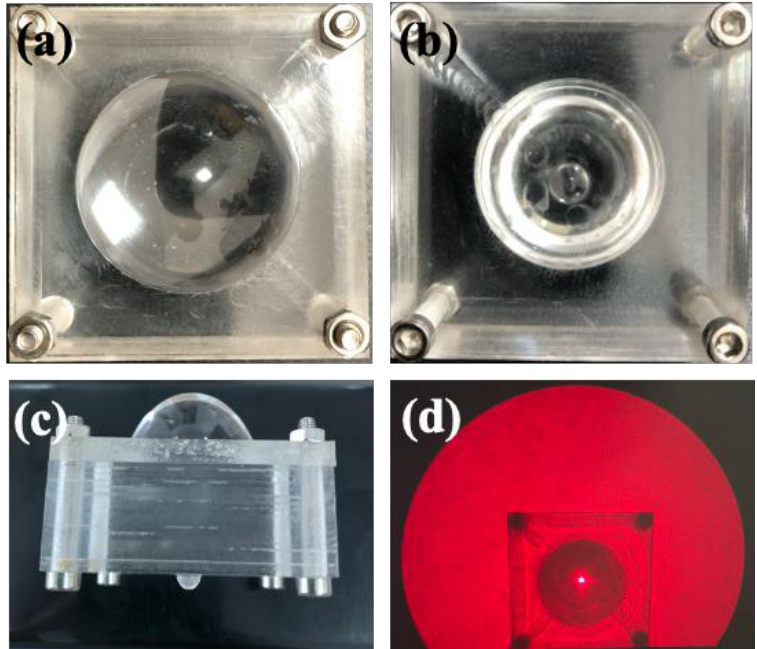
Figure 16. Photographs of the dual-lens concentrator unit from ( a ) objective lens side, ( b ) image lens side, ( c ) side-view of the dual-lens concentrator, ( d ) a focusing point in a mm-sized area using such concentrator under laser irradiation.